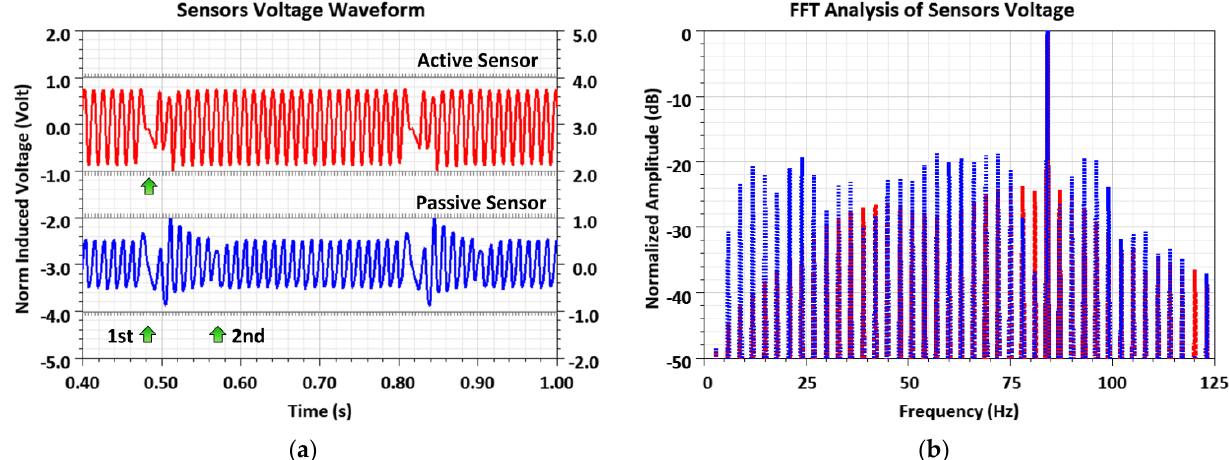
Figure 8. FEM model of a rotor with a broken bar: ( a ) normalized waveforms of the induced voltages in the sensors; ( b ) FFT analysis of induced voltage waveforms.